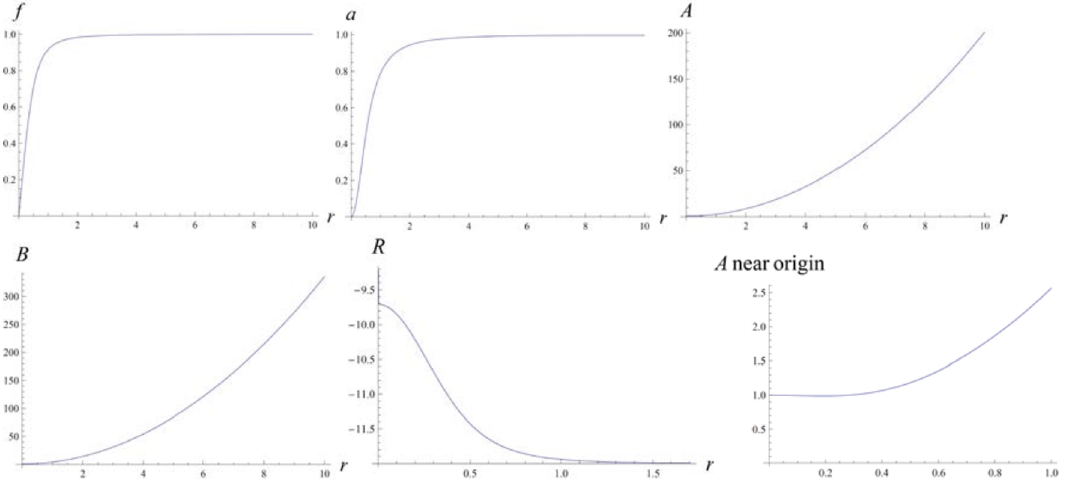
Figure 2 . Case II: n = 1 , v = 1 and Λ = − 2 . The Ricci scalar plateaus at − 12 which agrees with the expected 6Λ . The core of the matter profile f is smaller (the vortex is more compressed) than in case I and its mass is greater.